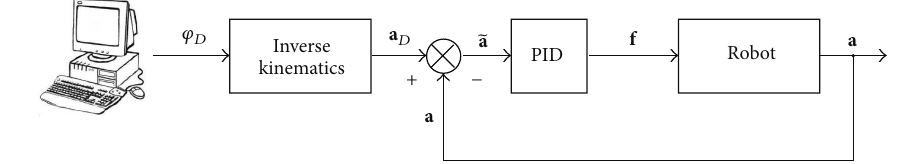
Figure 3: Joint space PID controller.